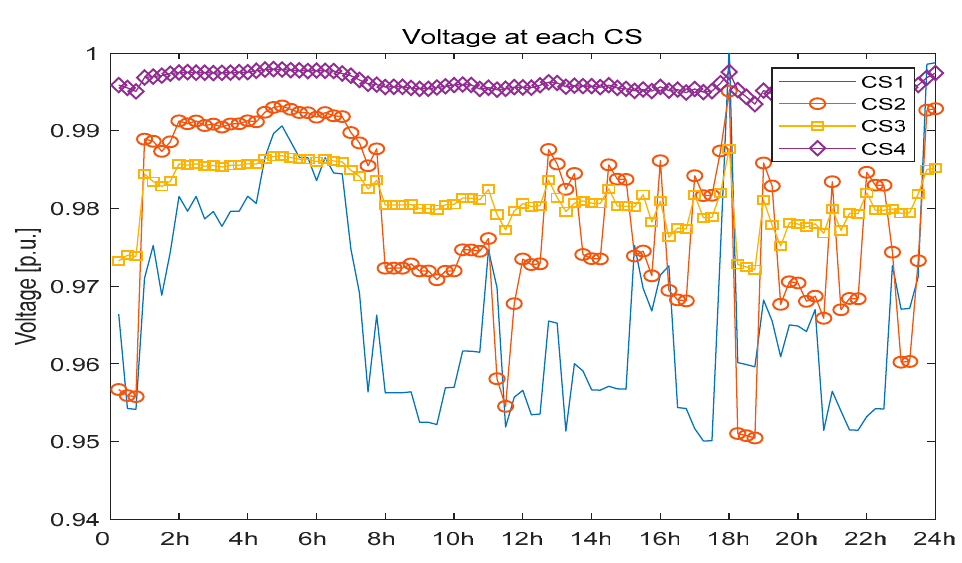
Figure 17. Voltage of CSs in Case 4.